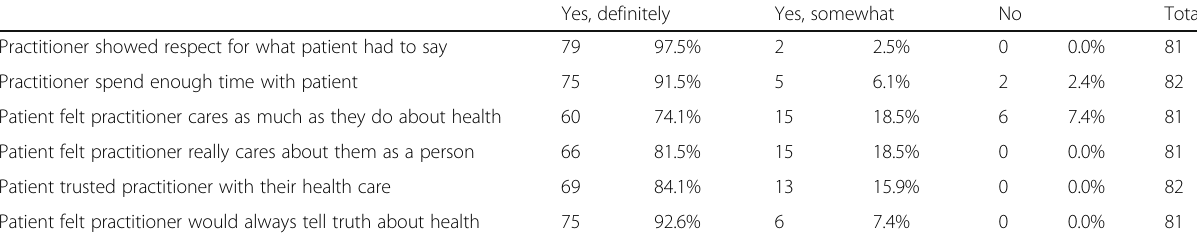
Table 3 Relationship and Communication with Practitioner ( n , %)